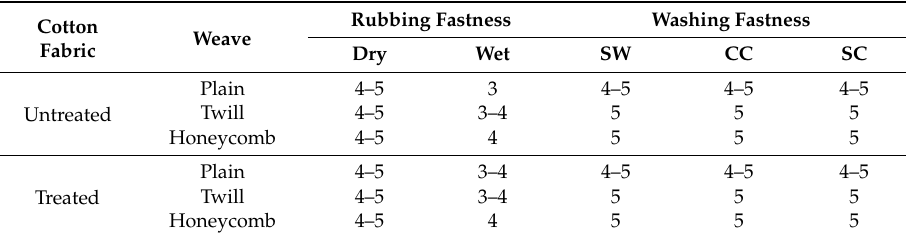
Table 3. Color fastness of ink-jet printed cotton fabrics with different